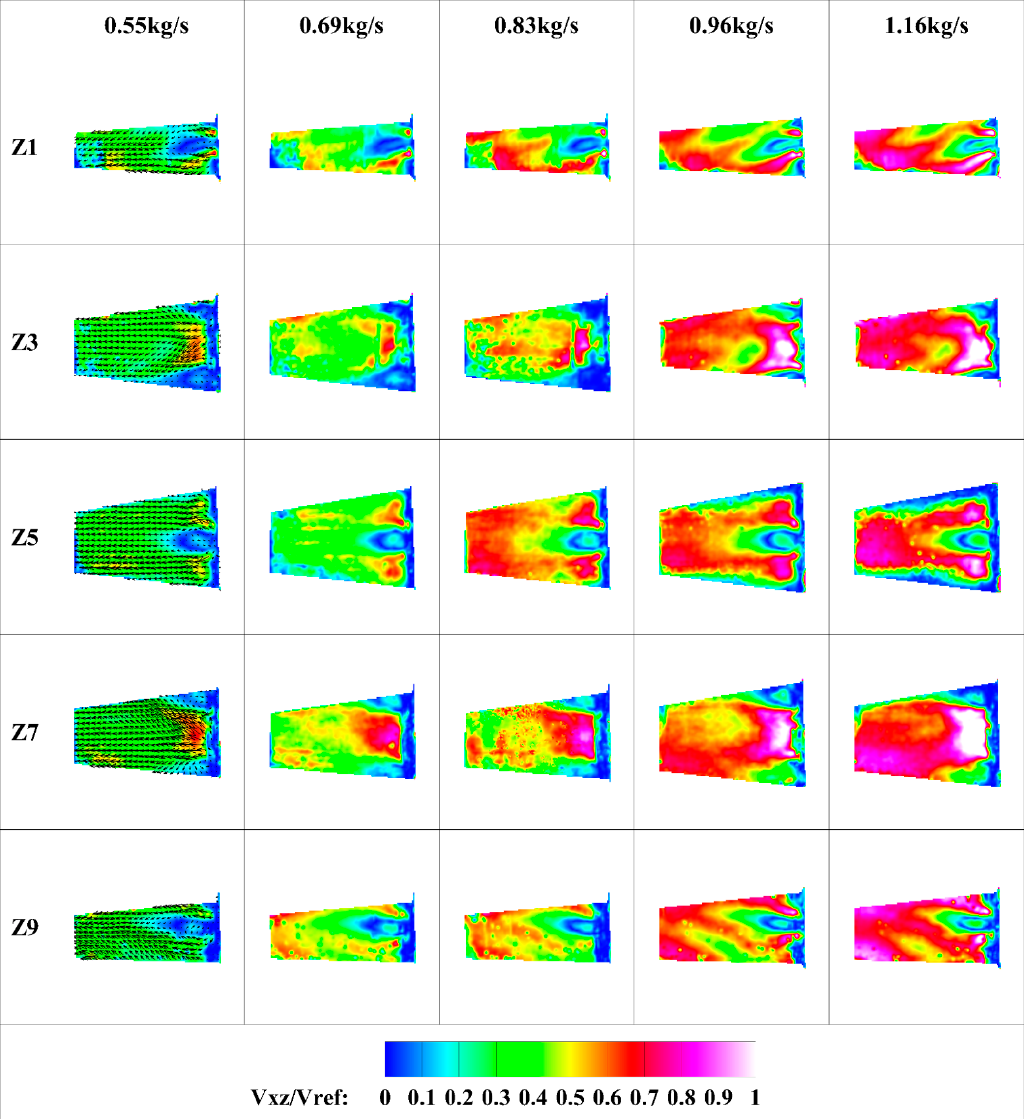
Figure 15. Experiment results: Longitudinal section contour.